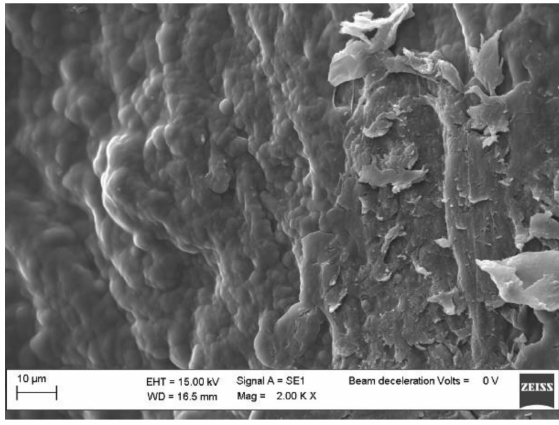
Figure 6. SEM micrograph of the BC-CP